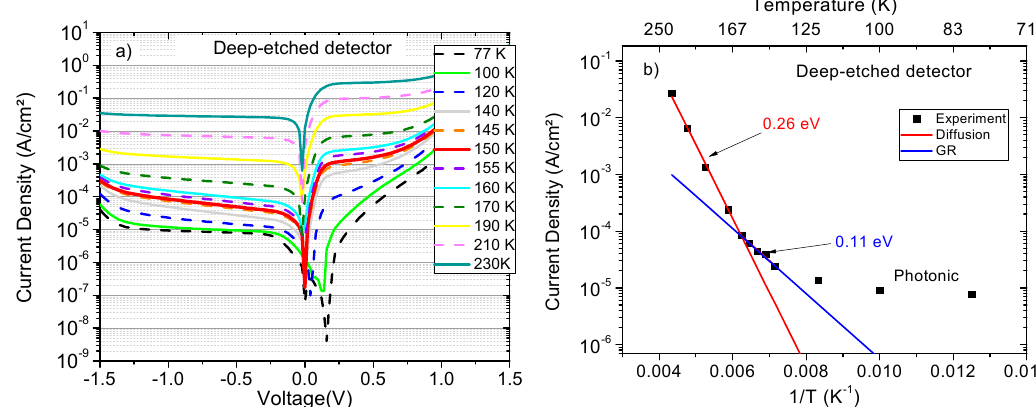
Figure 10. ( a ) Dark current density characteristics measured for a deep-etched device (mesa size 210 µm) at different temperatures from 77 to 230 K; ( b ) temperature dependence of dark current density at − 0.4 V.